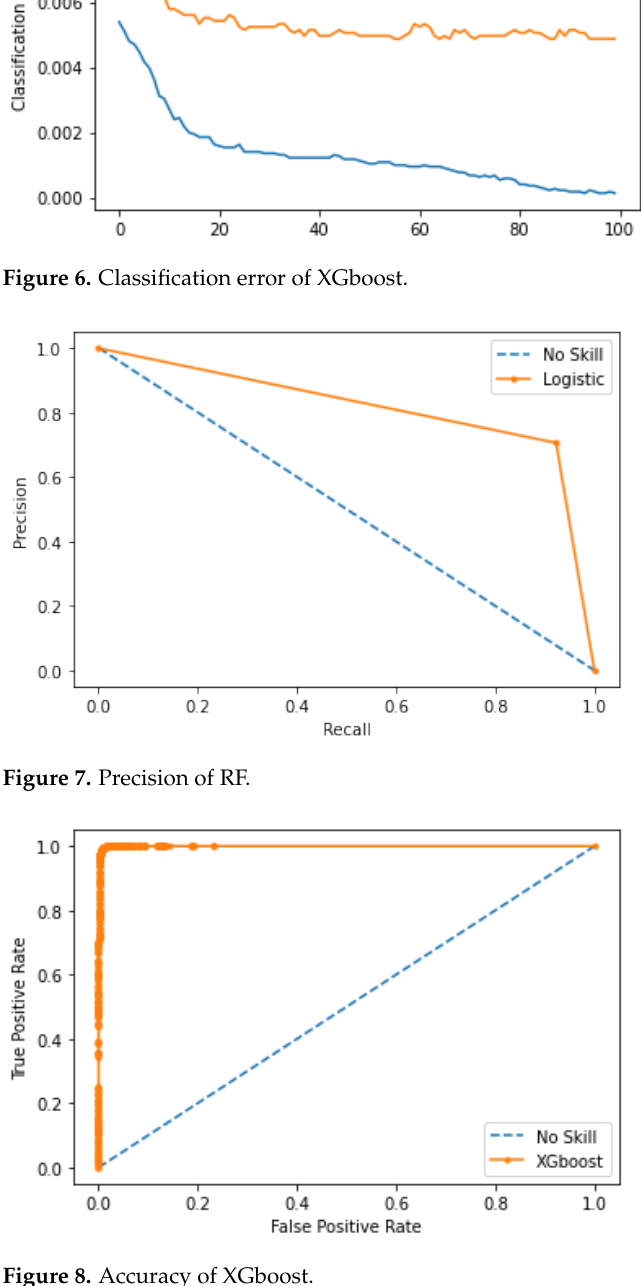
Figure 8. Accuracy of